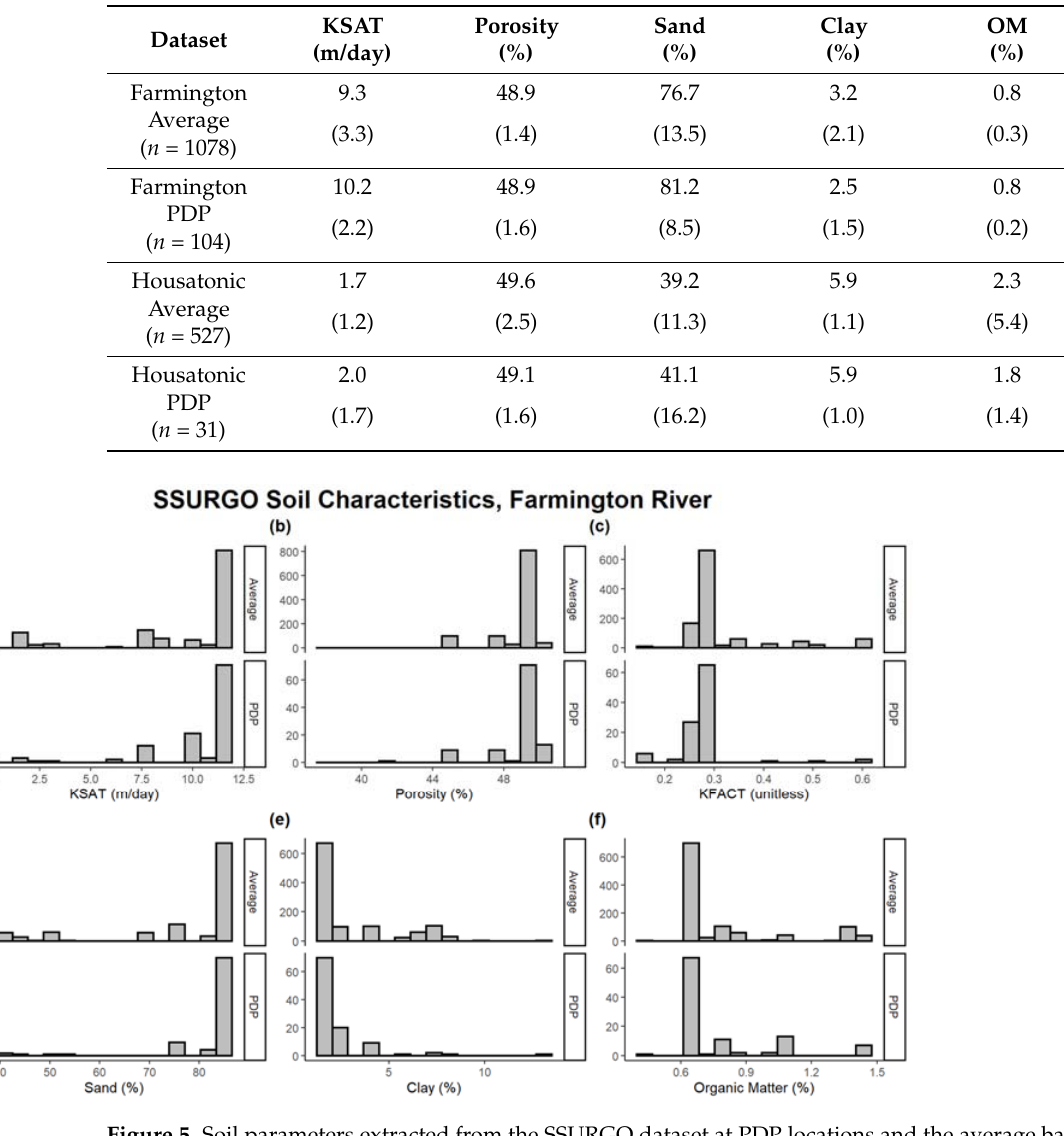
Figure 6. Soil parameters extracted from the SSURGO dataset at PDP locations and the average bank soil parameters from both banks of the Housatonic River reach for ( a ) KSAT, ( b ) porosity, ( c ) hy ‐ draulic conductivity factor (KFACT), ( d ) sand %, ( e ) clay %, and ( f ) organic matter %.